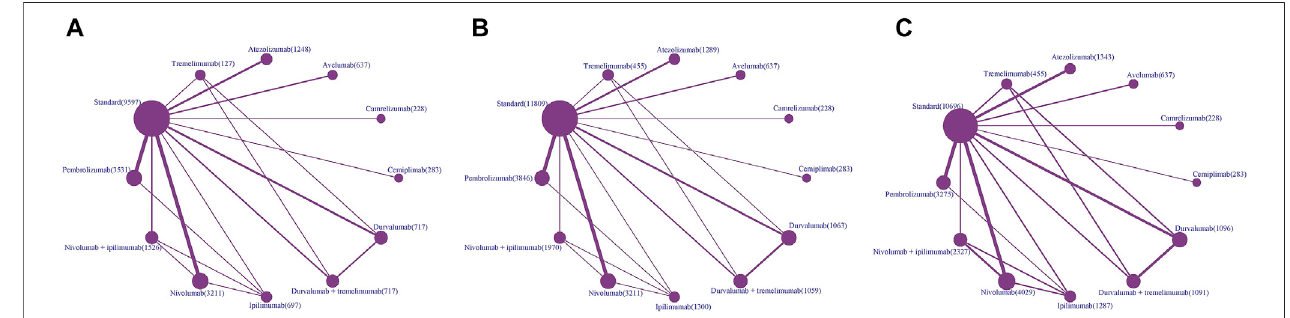
FIGURE 2 | Network plots of comparisons for PFS (A) , OS (B) and AEs (C) of different types of treatment-based network meta-analysis. Each node represents a treatment.Thesizeofthecircleisinproportiontothenumberofpatients.Thelinewidthisinproportiontothenumberofpatientsincludedinthedirectcomparisonoftwo